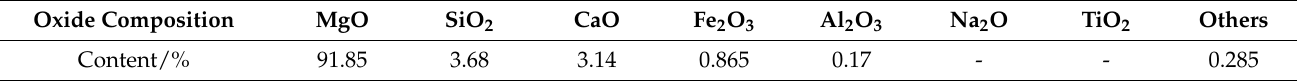
Table 1. Oxide composition of dead-burned magnesia